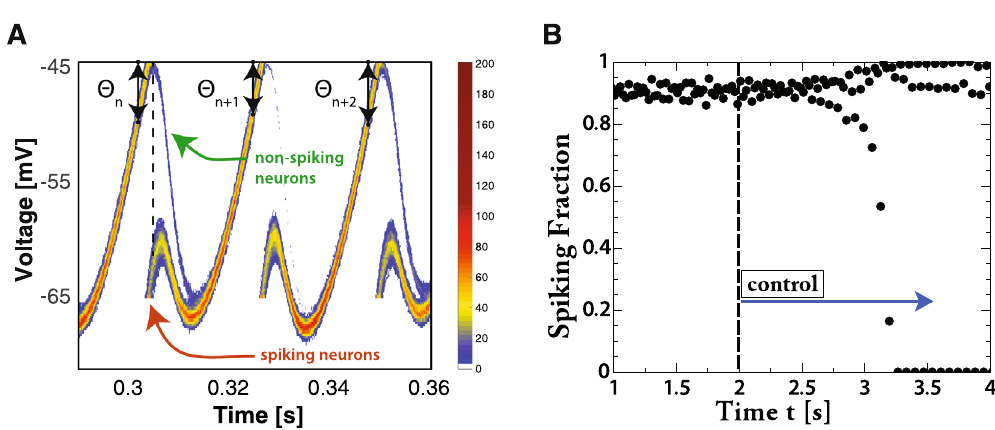
Figure 5. ( A ) Noise increases the synchronizability of rhythms by allowing a variable number of neurons to spike. Time-dependence of the voltage distribution function of the oscillators in the periodically forced network 2 with color indicating the number of neurons in bins of size 0.2 mV. Also shown is the lag θ n in each cycle. The red (green) arrow marks spiking (non-spiking) neurons. Parameters as in Fig. 4 except for ρ (2) = 1.02, γ 0 = 0.81, σ 2 = 0.3 s − 1 . ( B ) Synchrony is lost and replaced by a 3-cycle when the self-inhibition is rendered independent of the spiking fraction f spiking ( t ) via the control defined by equation (1) at t = 2 s. Parameters as in Fig. 4 except for ρ (2) = 0.975, σ 2 = 2 s − 1